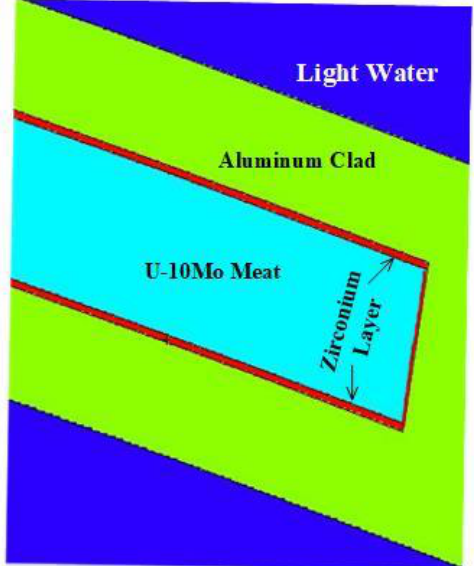
Figure 2. Middle-Cut-View of a single fuel plate containing U-10Mo meat surrounded by a thin zirconium layer, aluminum clad, and light water.